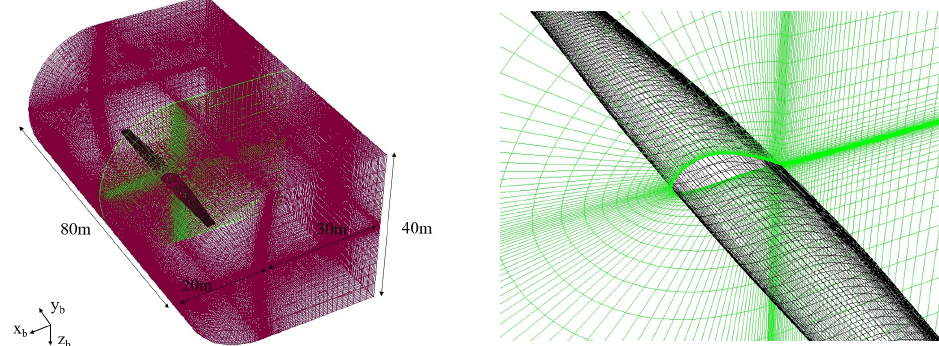
Figure 7. Wing component mesh. Purple, component mesh boundary with overset b.c.; green, internal intersection; black, wing surface with no-slip wall b.c.